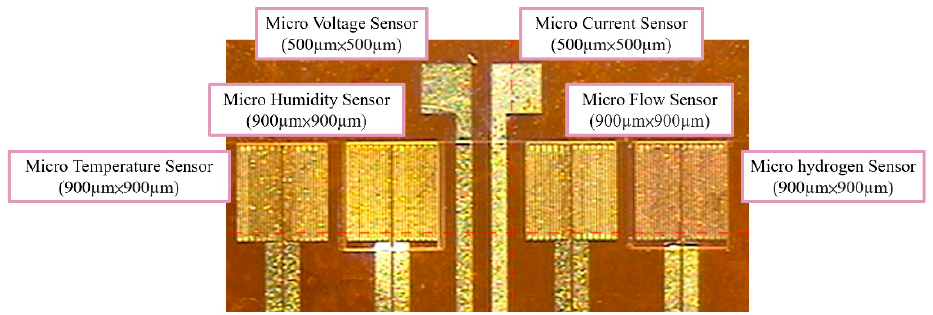
Figure 1. The process diagram of the flexible 6-in-1 microsensor.